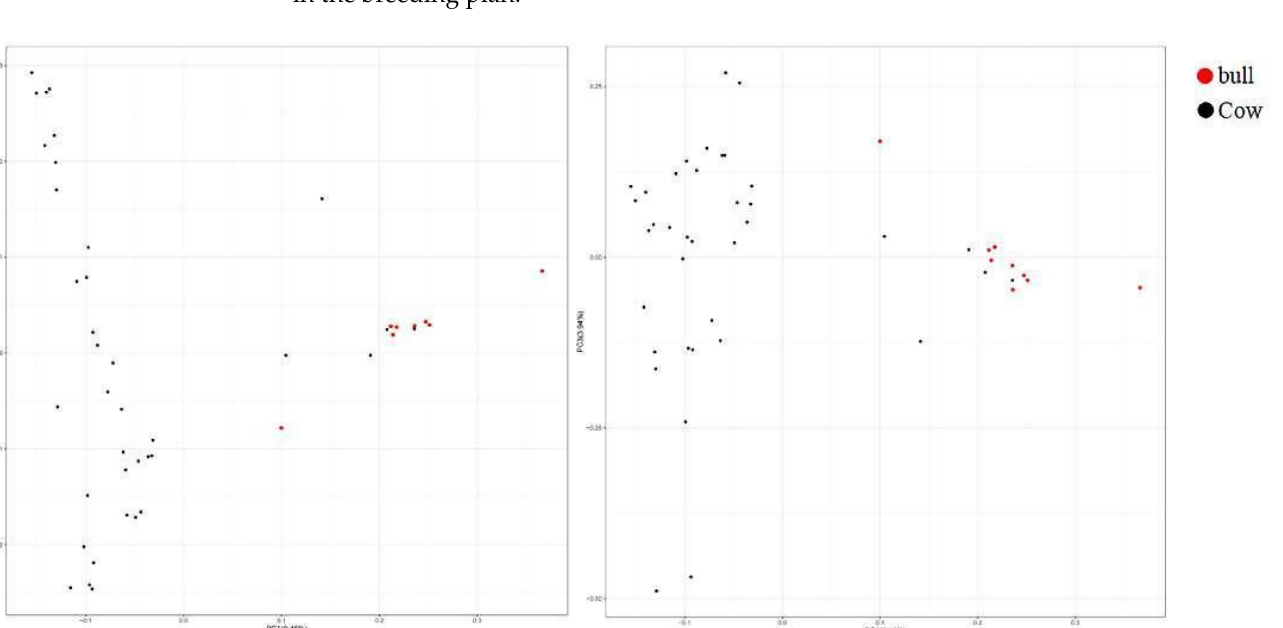
Figure 7. Visualization results of the genome kinship analysis. Note: This figure shows the ge- nomic kinship coefficient between two individuals. The closer the color, the closer the kinship. The abscissa and ordinate indicate the individual IDs.